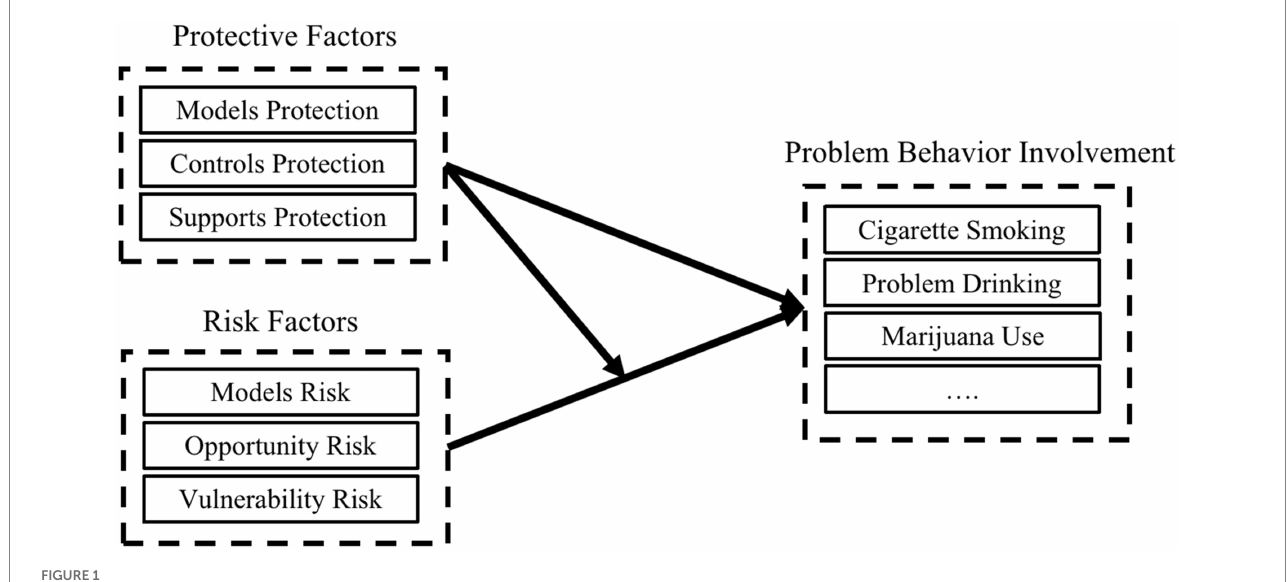
FIGURE 1 The original protection–risk